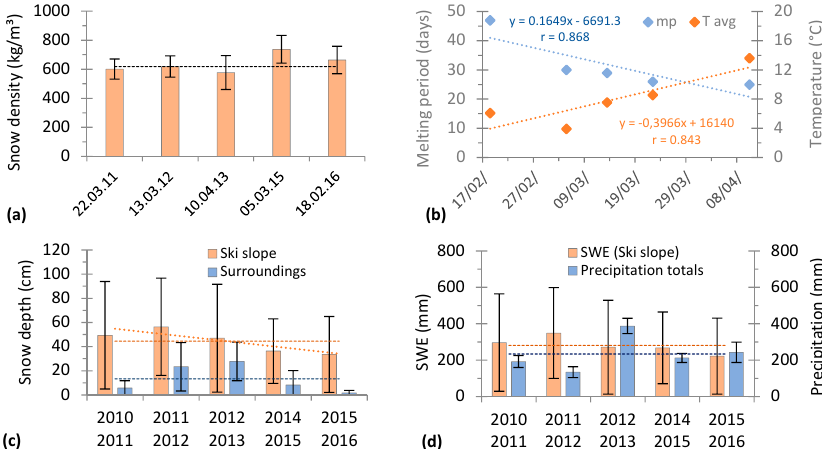
Figure 9. ( a ) Mean density of the residual snowpack on the artificially covered ski slope after the disappearance of natural snow in the surroundings (five seasons); ( b ) Relationship between the date in the season (five seasons displayed) when the natural snow cover on the off-piste sites was melted away and the melting period (mp) or temperature (T avg). The melting period expresses the prolonged duration of the melting of the snowpack on the artificially covered ski slope compared to off-piste sites. The temperature expresses the mean daily average temperature during the melting period; ( c ) Mean depth of snow on the artificially covered ski slope (at the end of winter season) in comparison to the mean seasonal depth (XII–III) of natural snow in the surroundings; ( d ) Mean snow water equivalent (SWE) of the ski slope snowpack (at the end of the winter season) in comparison to the seasonal precipitation totals (XII–III). The horizontal dashed lines indicate the mean value except for subfigure “b”. Mean values are displayed with standard deviation bars.